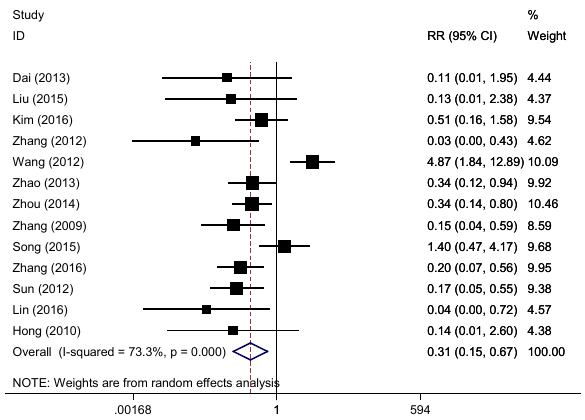
Figure 5: Forest of diarrhea of Pemetrexed versus Gefitinib as second-line treatment for advanced